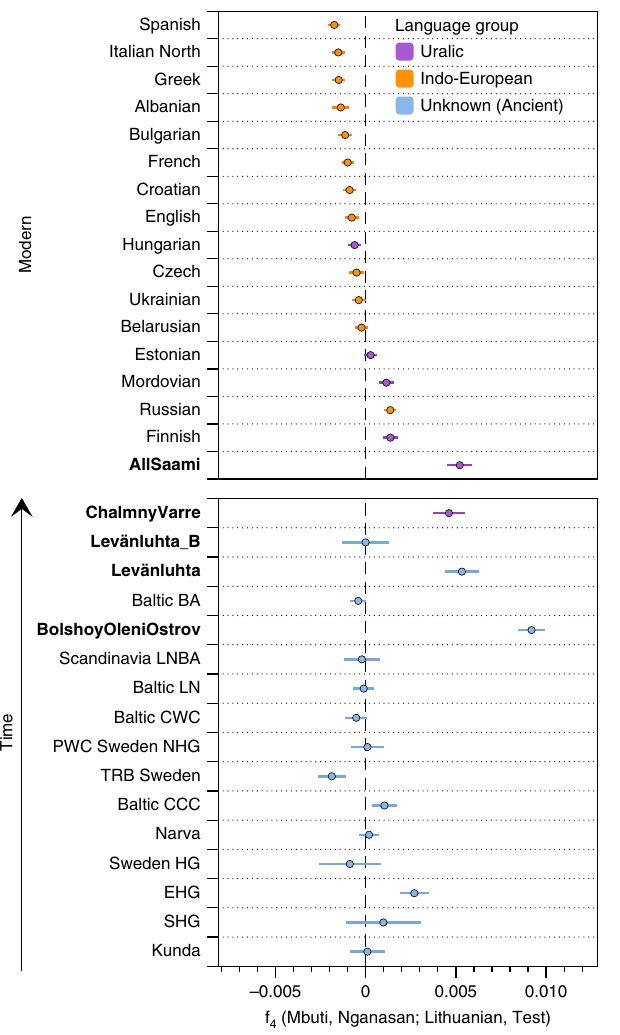
Fig. 3 Calculated f 4 (Mbuti, Nganasan; Lithuanian, Test). Modern populations are sorted by f 4 magnitude; ancient populations are sorted through time. Populations are coloured based on language family, with Ancient individuals with unknown language shown in blue. “ AllSaami ” refers to a grouping including the 2 individuals from the SGDP (Saami (SGDP)) and the high-coverage modern Saami shotgun genome in this study (Modern Saami). Individuals from this study are indicated by labels in bold. Error bars represent 3 standard errors, to indicate signi fi cant difference from 0. Source data are provided as a Source Data fi